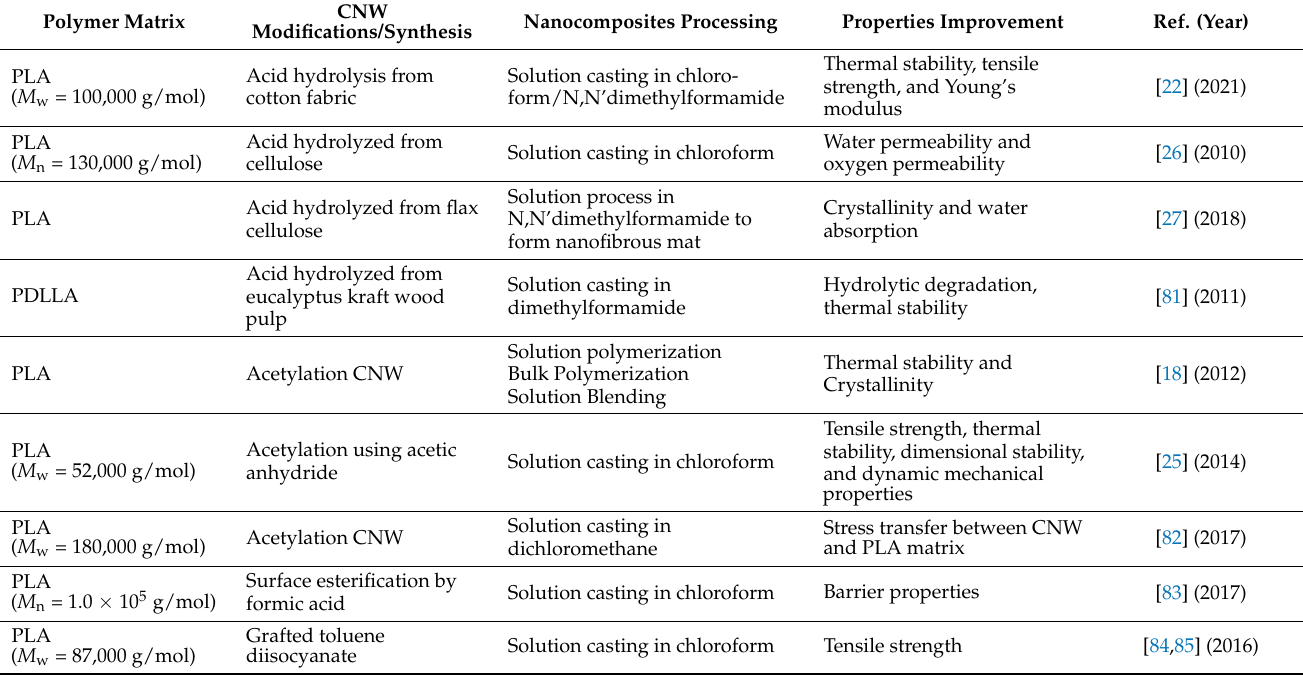
Table 2. Polymer matrix, surface modification, processing, and properties of PLA–CNW nanocomposites. Polymer